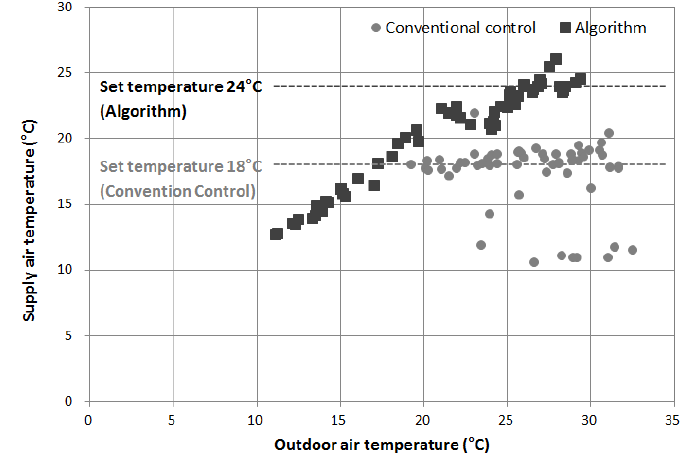
Figure 9. Changes in supply air temperature in the OAP according to outdoor air